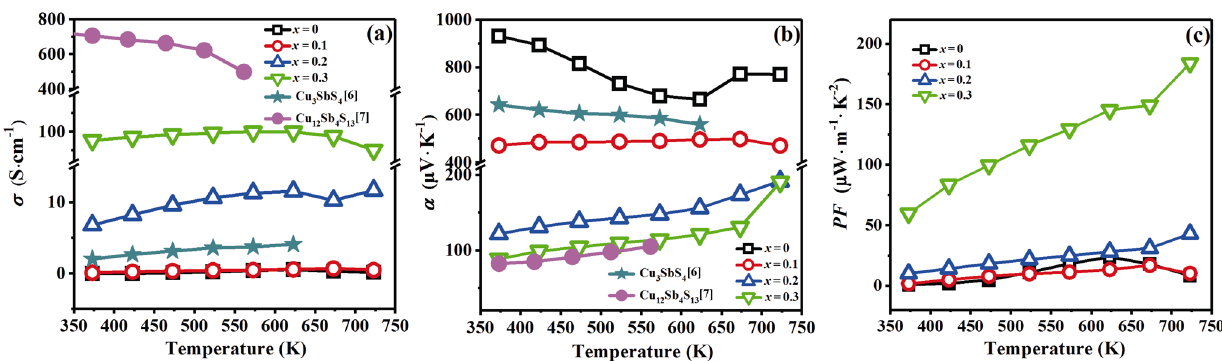
Fig. 6 Temperature dependence of electrical transport properties for the bulk samples with the mole ratio of (1– x )CuSbS 2 – x Cu 1.8 S ( x = 0, 0.1, 0.2, 0.3). (a) Electrical conductivity ( σ ), (b) Seebeck coefficient ( α ), and (c) power factor